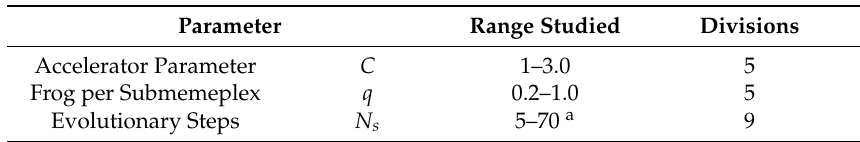
Table 2. Range used for each SFLA